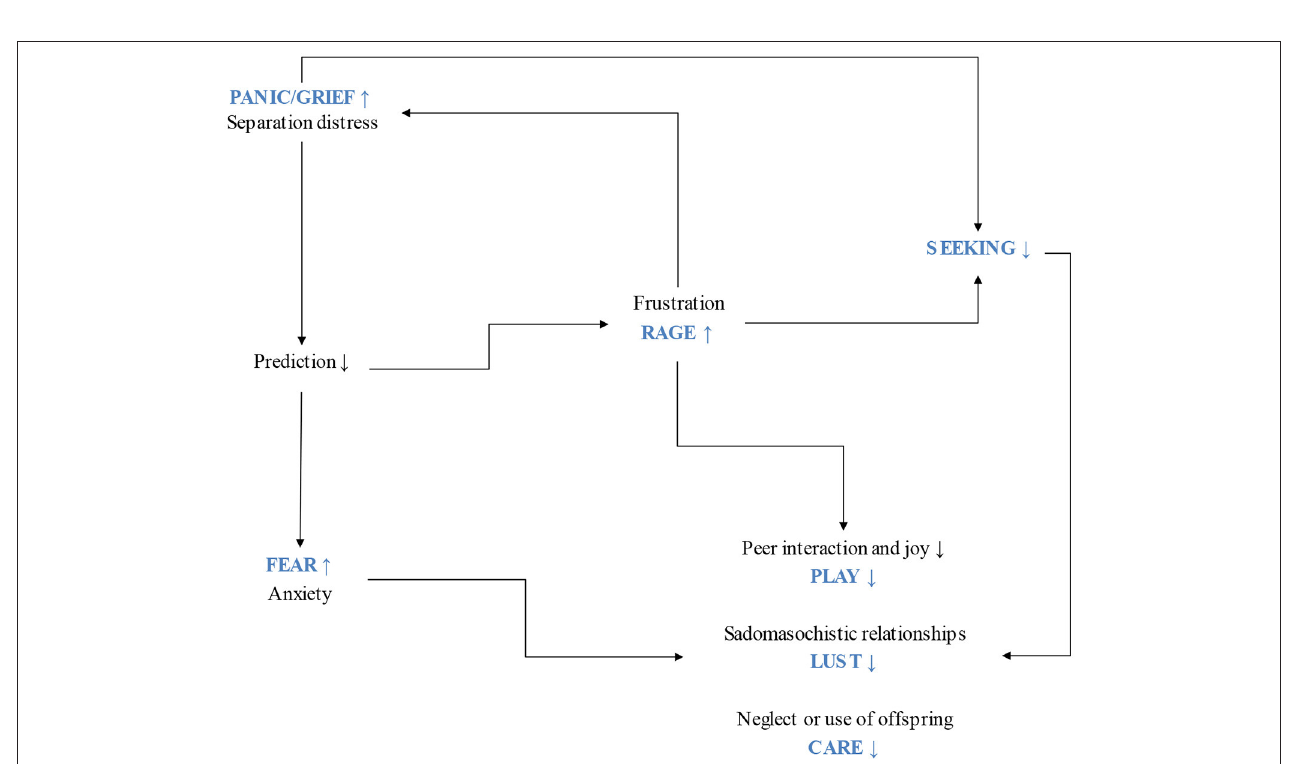
FIGURE 3 | Protracted separation distress affects the basic emotion